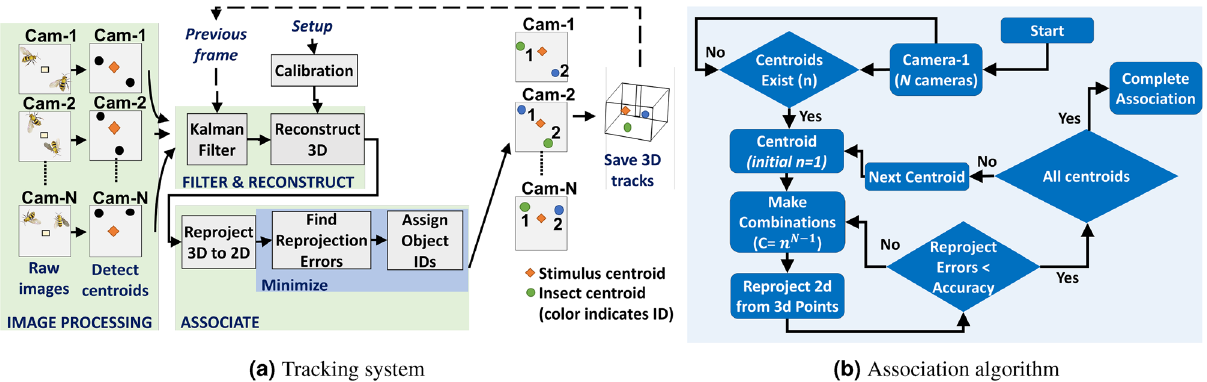
Figure 11. Flowchart of tracking ( a ) and association algorithms ( b ) for VISIONS multi-agent